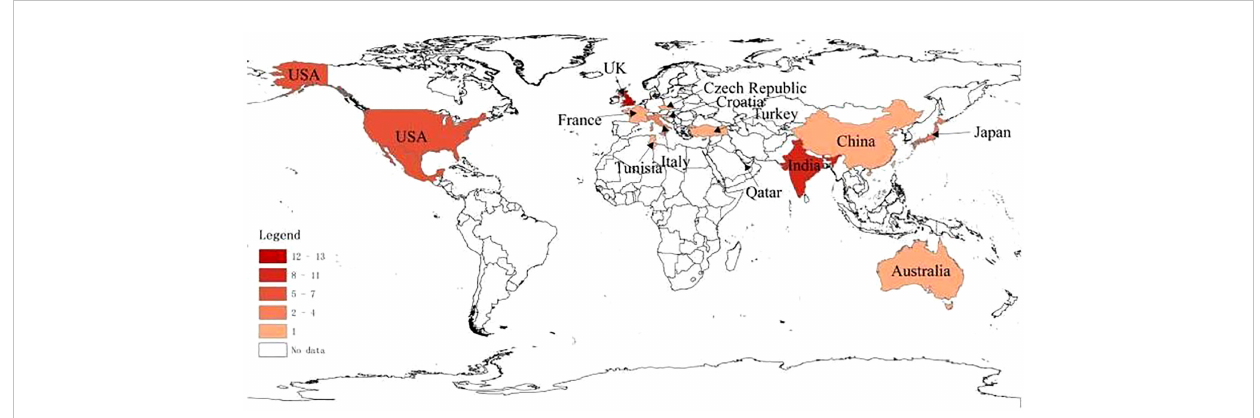
FIGURE 2 Geographic distribution of cases of Guillain – Barre syndrome after COVID-19 vaccination.